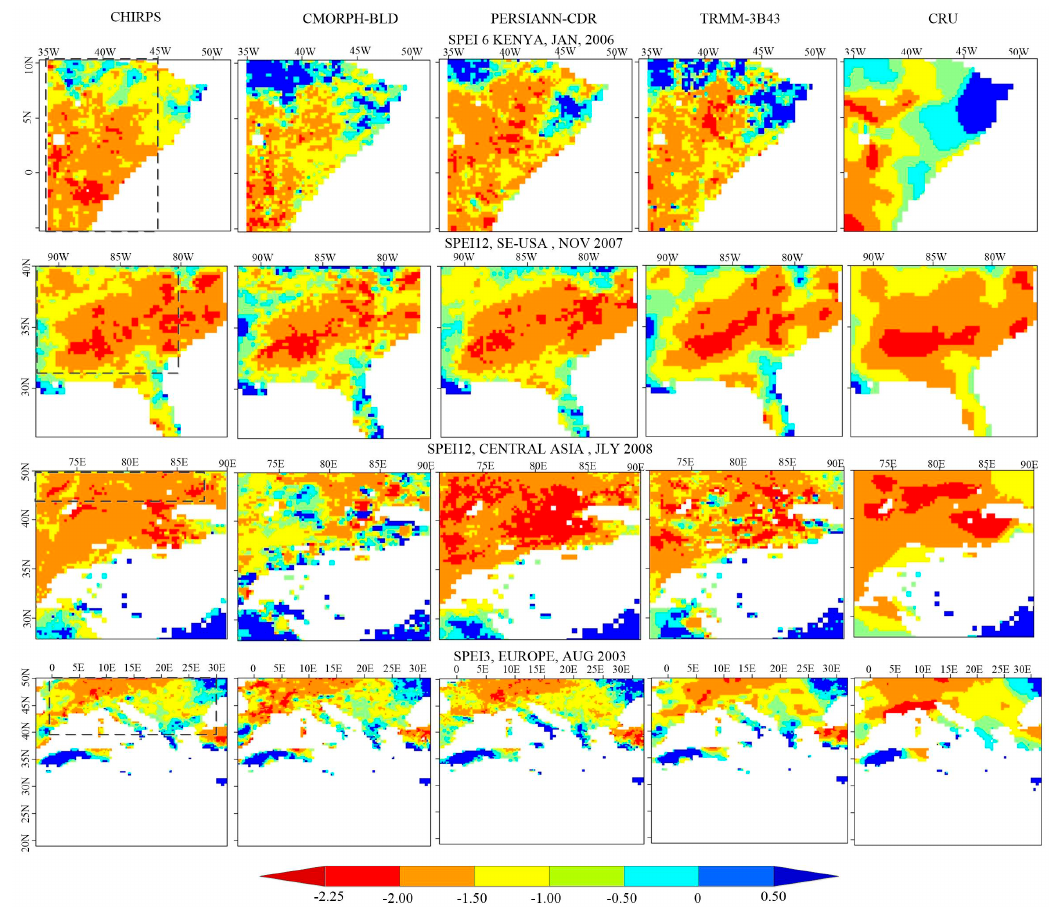
Figure 8. Spatial monthly SPEIs pattern of CHIRPS, CMORPH-BLD, PERSIANN-CDR, TRMM-3B43, and CRU gauges for four drought events. The dotted box indicates the actual extent used to calculate the area averaged SPEIs and drought area proportion in Figures 6 and 7.